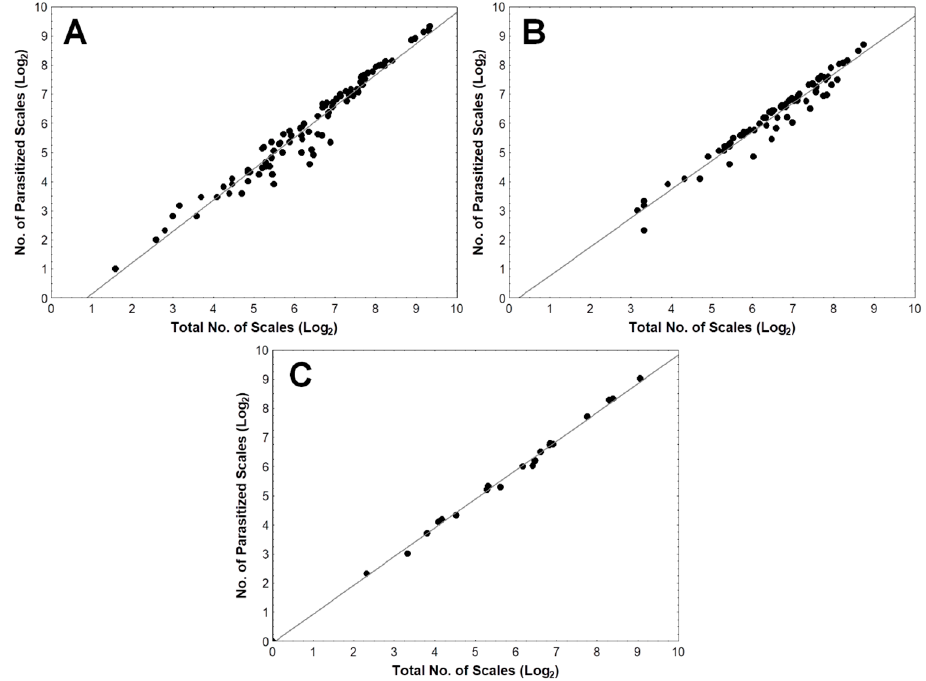
Figure 5. Correlation and regression of the number of parasitized scales against the total number of scales across the three sampling periods: ( A ) August 2014 (r = 0.9764, r 2 = 0.9534, p = 0.0000); ( B ) December 2014 to January 2015 (r = 0.9764, r 2 = 0.9535, p = 0.0000); ( C ) June 2015 (r = 0.9988, r 2 = 0.9976, p = 0.0000).